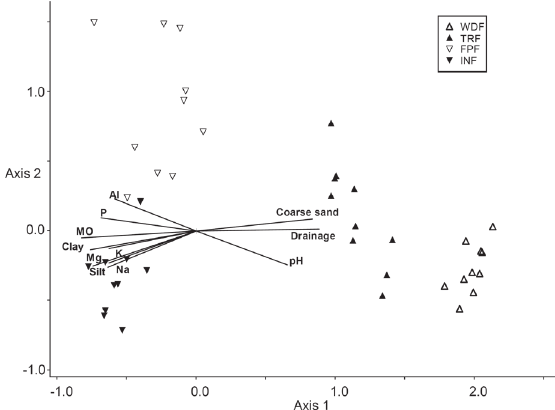
Figure 4 - Canonical Correspondence Analysis (CCA) of the 40 plots sampled and chemical soil features. INF=Inundated Forest; FPF=Floodplain Forest; TRF=Transitional Forest; WDF=Well- drained Forest; pH=acidity in H2O; Na=Sodium; Mg=Magnesium; k=Potassium; P=Phosphorus; Al=Aluminum; MO=Organic